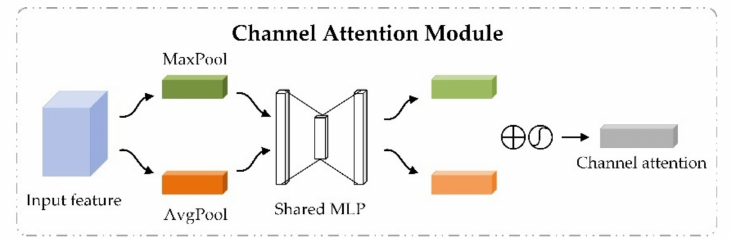
Figure 2. The channel attention module in convolutional block attention module.